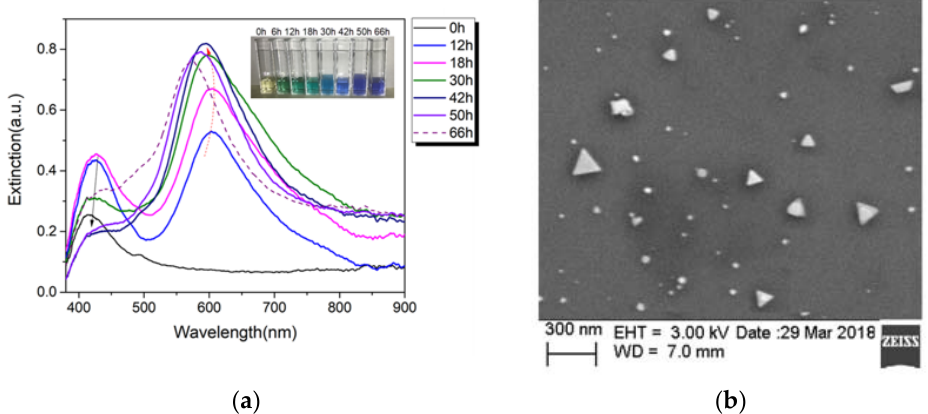
Figure 3. ( a ) The extinction of reaction solution during photoinduced conversion of silver nanospheres to nanoprisms, the inset shows the color evolution with irradiation times; ( b ) SEM image of the AgPRs synthesized by irradiation with a 532-nm laser, 30 h.